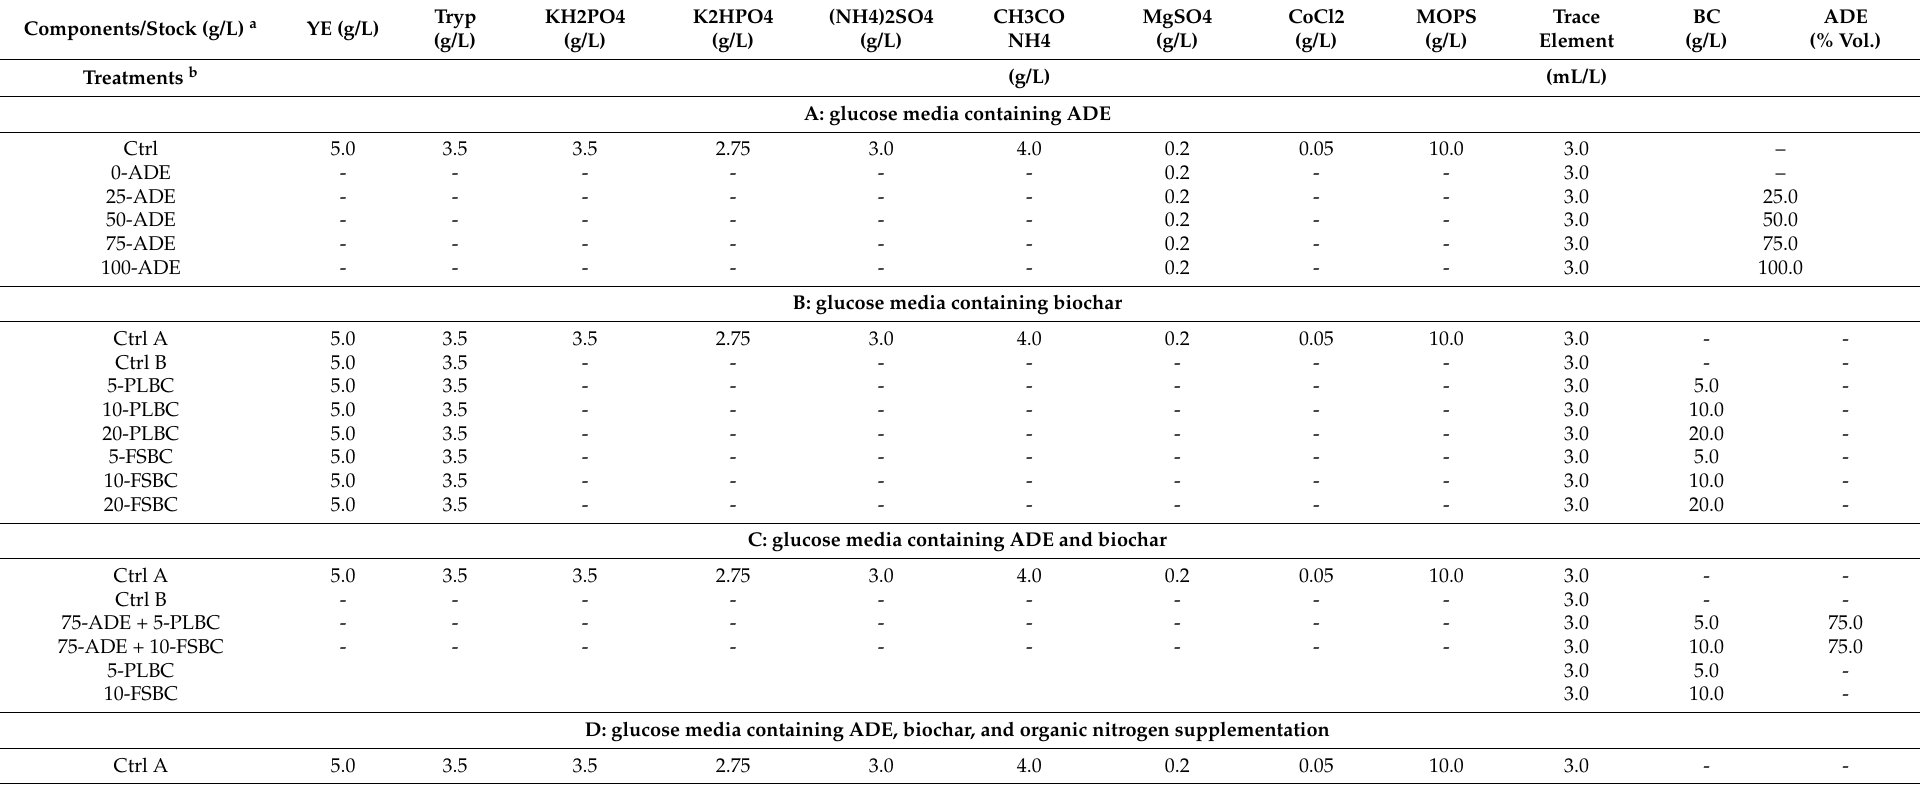
Table 1. Compositions of treatments A, B, C, and D used in the 2,3-butanediol